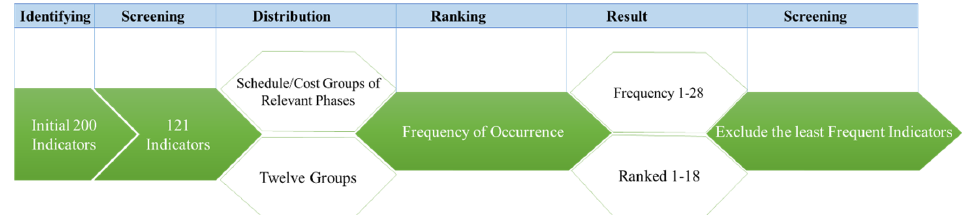
Figure 2. The screening process to prepare the initial list of indicators.